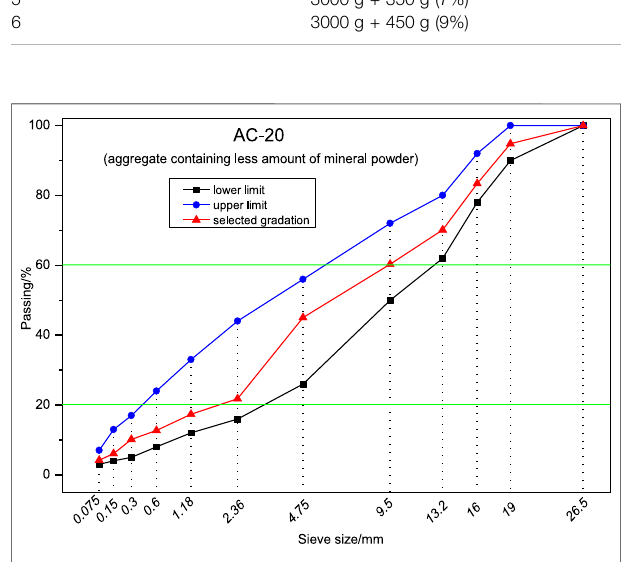
FIGURE 2 | Gradation curve of AC-20 asphalt